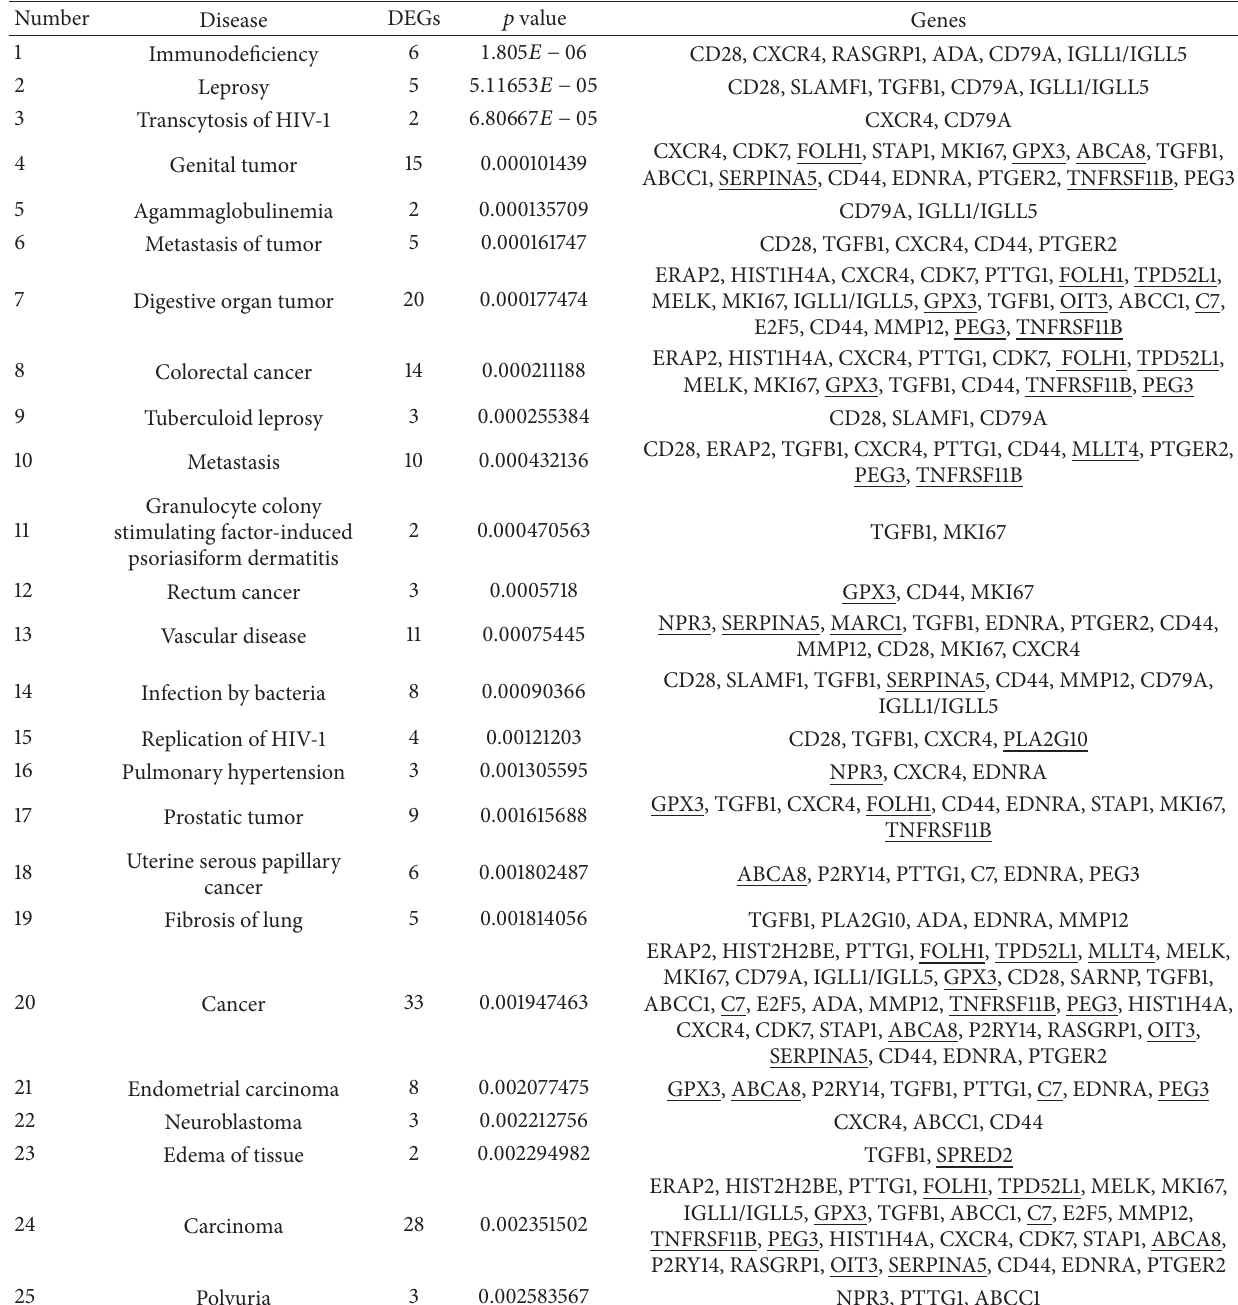
Table 4: Top 25 diseases associated with IPH in Ingenuity